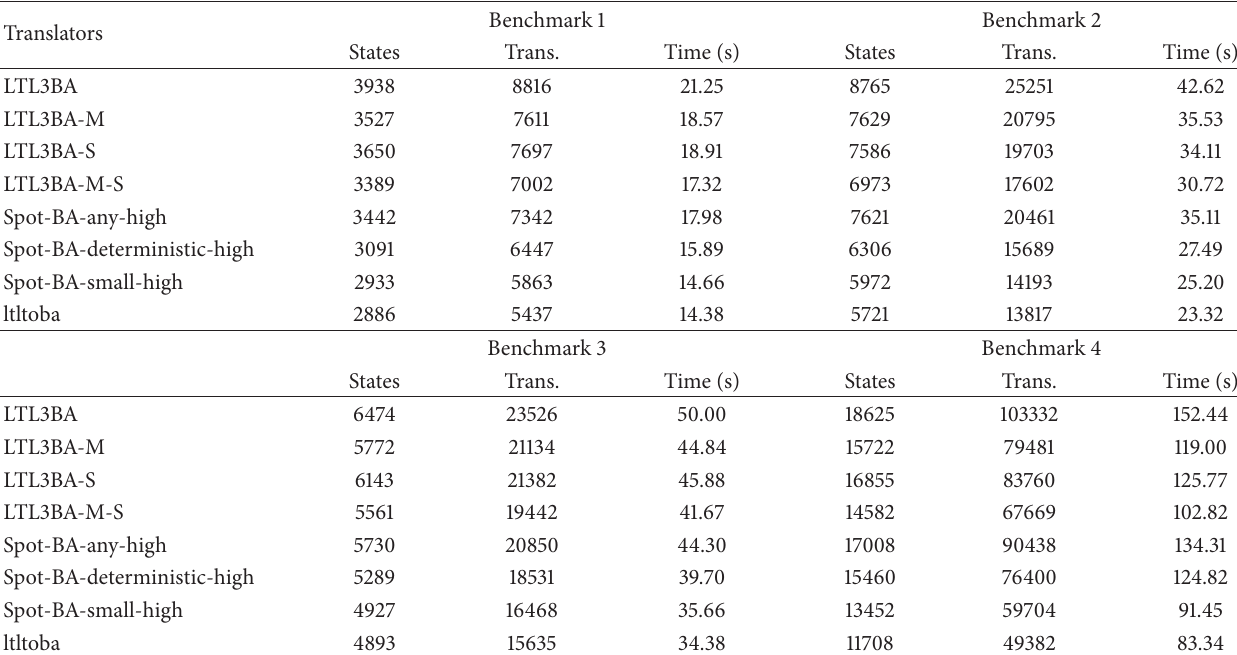
Table 2: LBTT parameters used for formulae